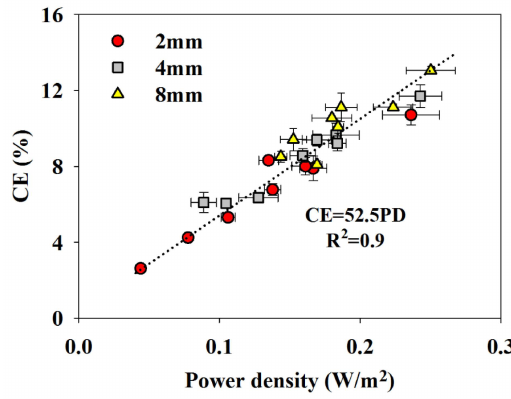
Figure 2. Coulombic efficiency versus peak power density (PD) with different separators in the 2 mm, 4 mm, and 8 mm